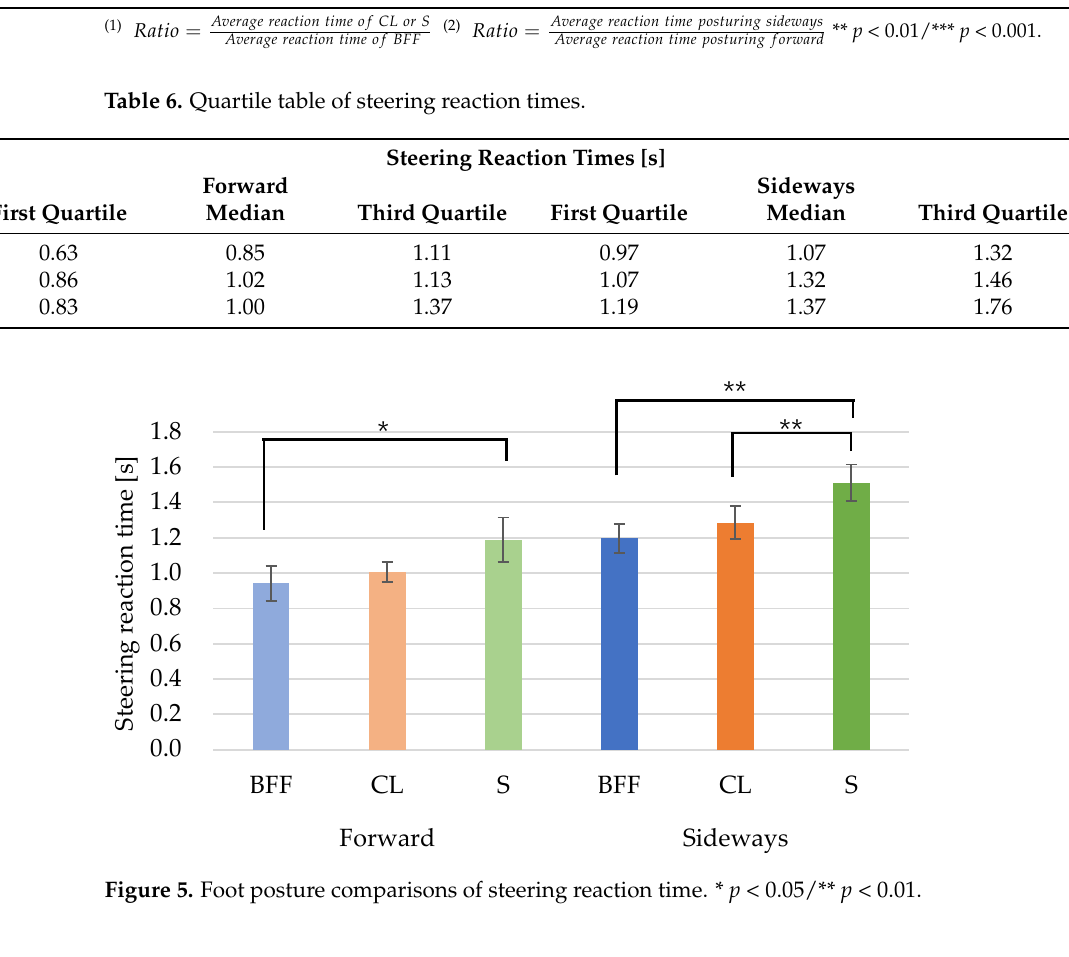
The braking versus steering reaction times for the forward-BFF (0.80 s versus 0.94 s) and sideways-BFF (1.03 s versus 1.2 s) postures suggest that the mean breaking reaction time was faster than the mean steering reaction time. Conversely, for the forward-CL (1.22 s versus 1.01 s), sideways-CL (1.47 s versus 1.29 s), forward-S (1.52 s versus 1.19 s), and sideways-S (1.69 s versus 1.51 s) postures, the mean steering reaction time was faster than the braking reaction